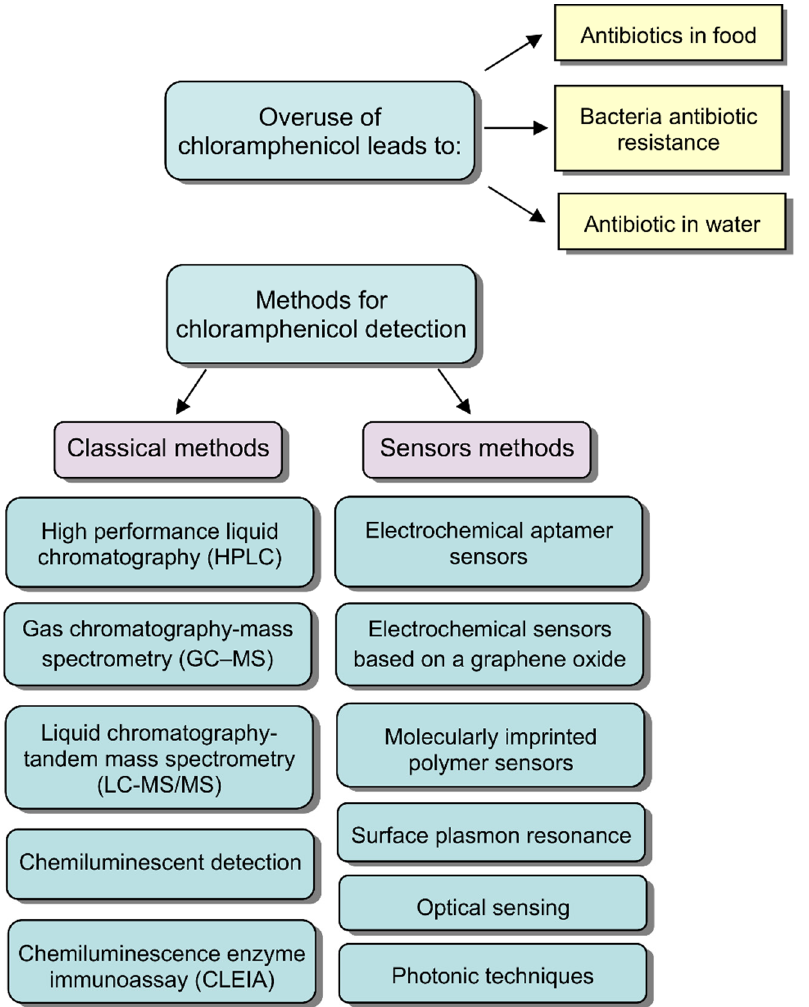
Figure 2. The general methods for the chloramphenicol analysis.